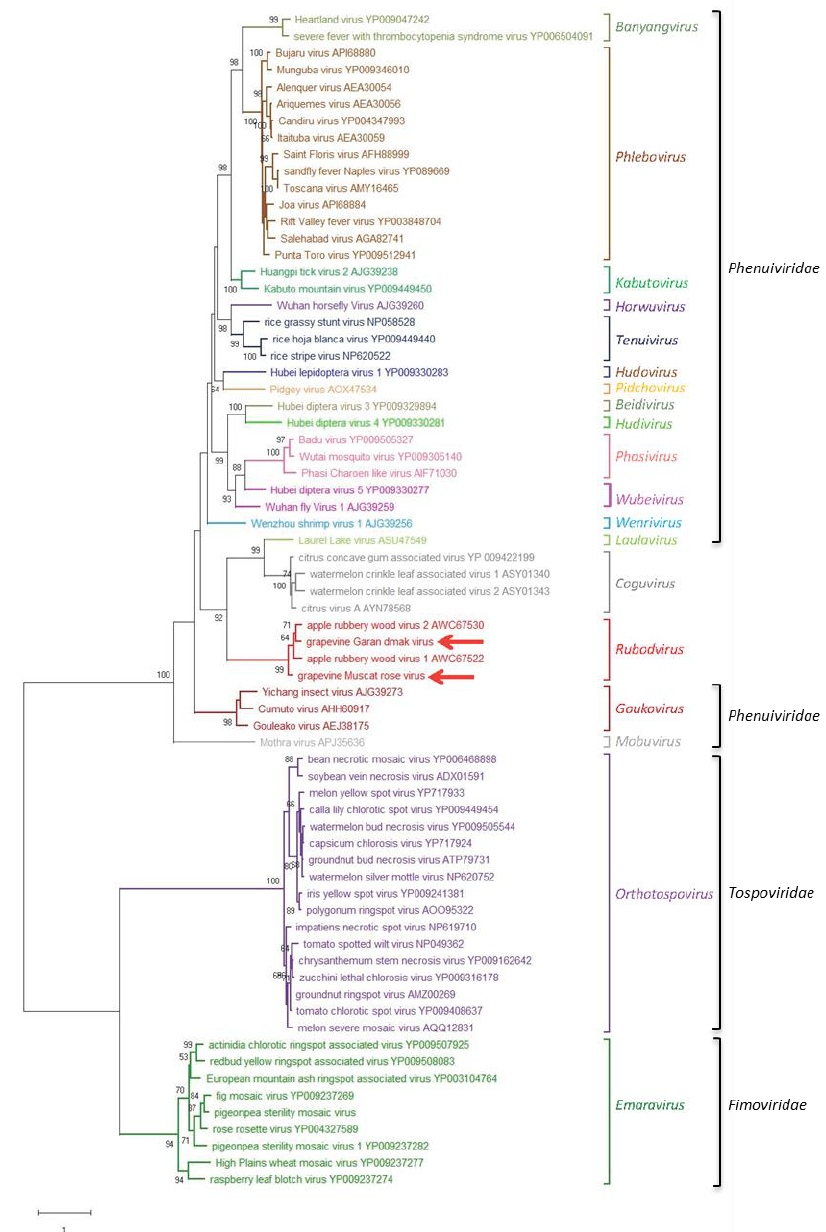
Figure 4. Maximum likelihood phylogenetic tree inferred from the RNA-dependent RNA polymerase conserved core domain of grapevine Muscat rose virus, grapevine Garan dmak virus and representative members of all the genera in the family Phenuiviridae , the plant-infecting negative-stranded RNA viruses in the genera Emaravirus , Orthotospovirus , Coguvirus , and the tentative genus Rubodvirus . The names of the viruses and the accession numbers are shown at the branch tip. Recognized and tentative genera are reported on the right, likewise, corresponding families. Bootstrap probabilities for each branch node were estimated using 500 replicates and those above 50% are shown. Tree branches are proportional to the genetic distances, with the scale bar indicating substitutions per amino acid